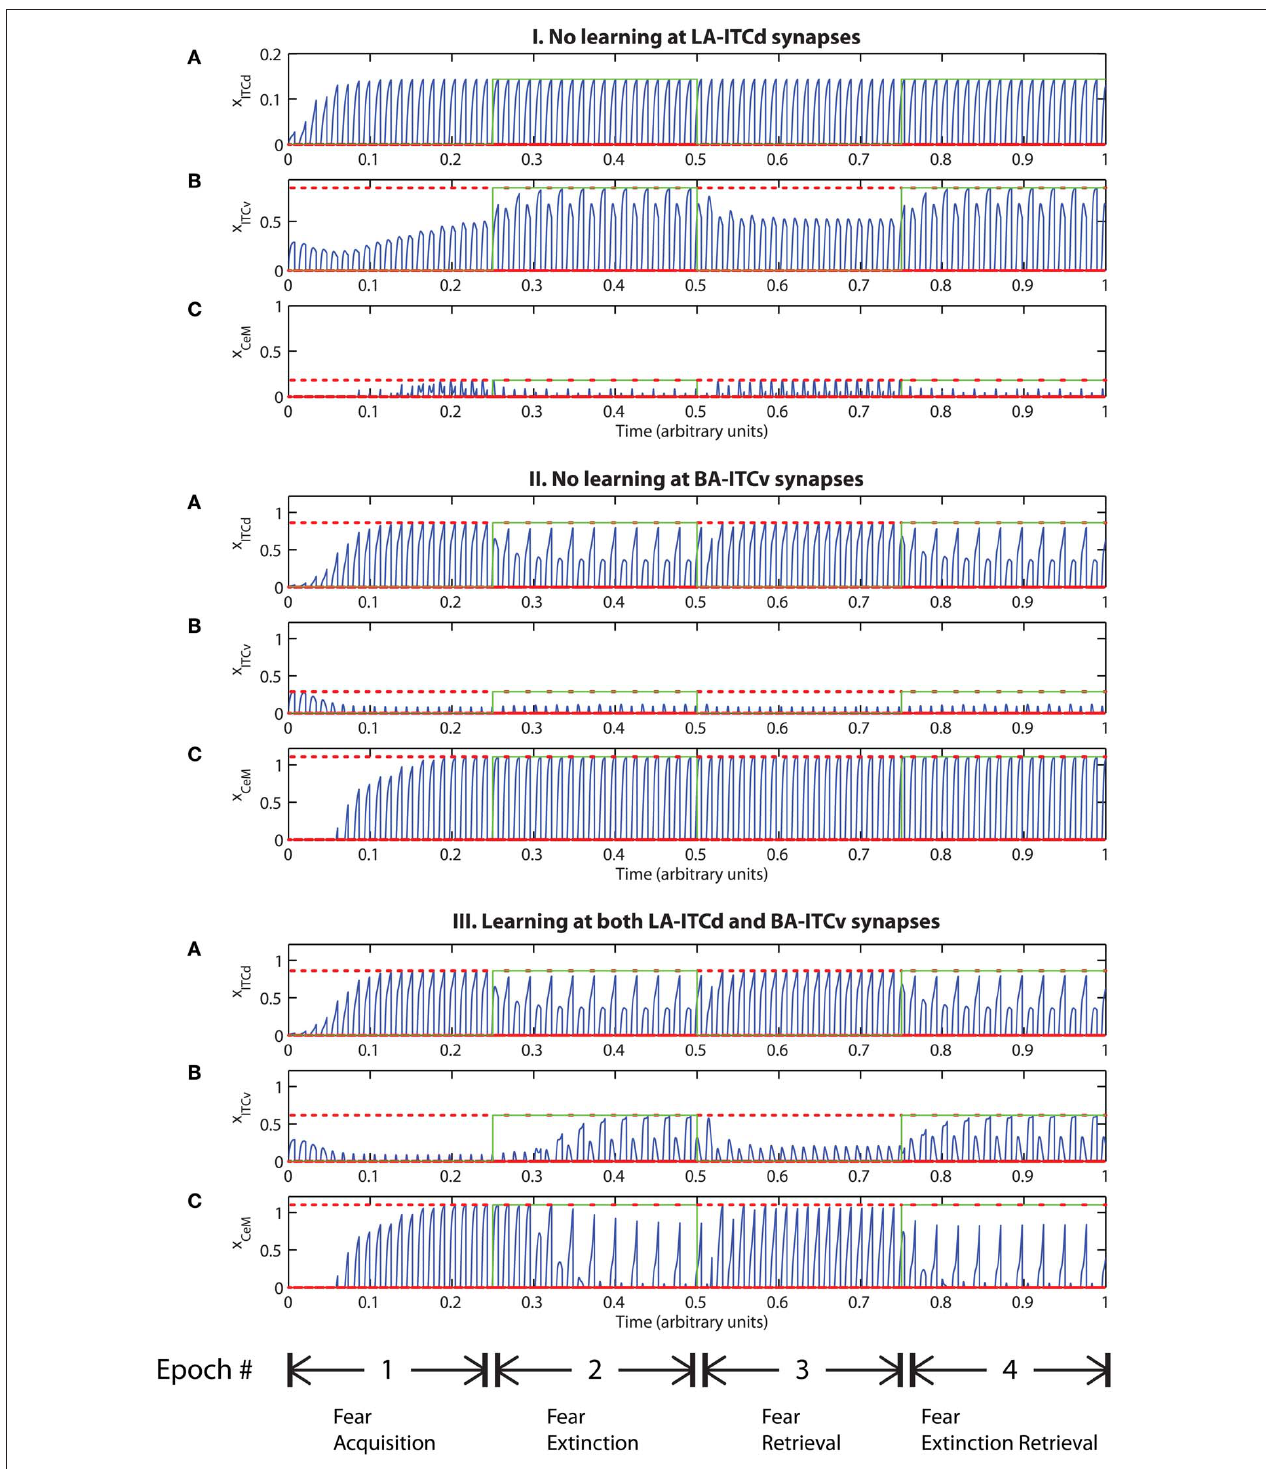
FIGURE 9 | Time evolution of model cell activities during “confusing” outcomes. Only one of the two overlapping CS signals is extinguished. (I) No learning occurs at the LA-ITCd synapses. (II) No learning occurs at the BA-ITCv synapses. (III) Learning occurs in both LA-ITCd and BA-ITCd weights. Each plot shows the temporal evolution of a single cell over four consecutive epochs, with the y-axis representing strength of activation. In